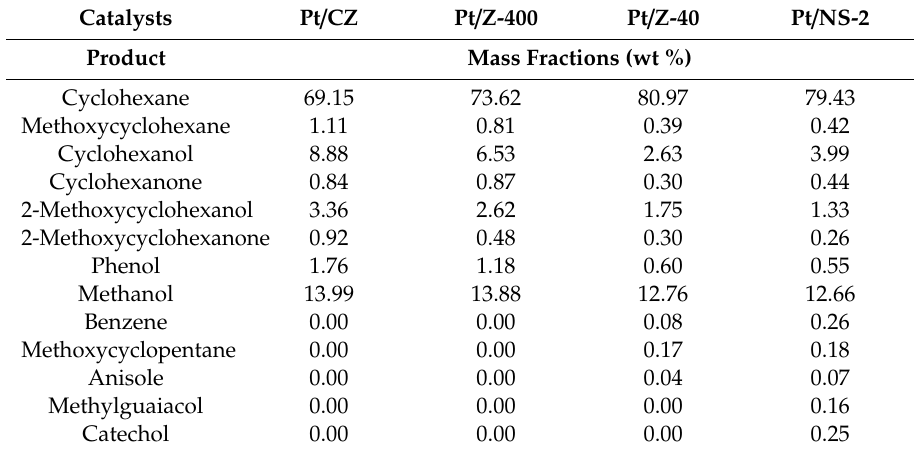
Table 4. Mass fractions of various products obtained during the hydrodeoxygenation (HDO) of guaiacol over di ff erent Pt-loaded catalysts a